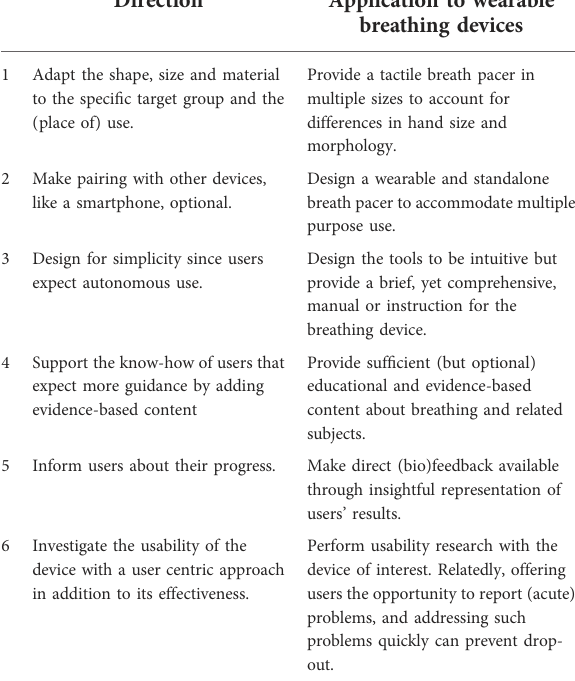
TABLE 5 Recommendations for developers of eHealth tools and wearable breathing